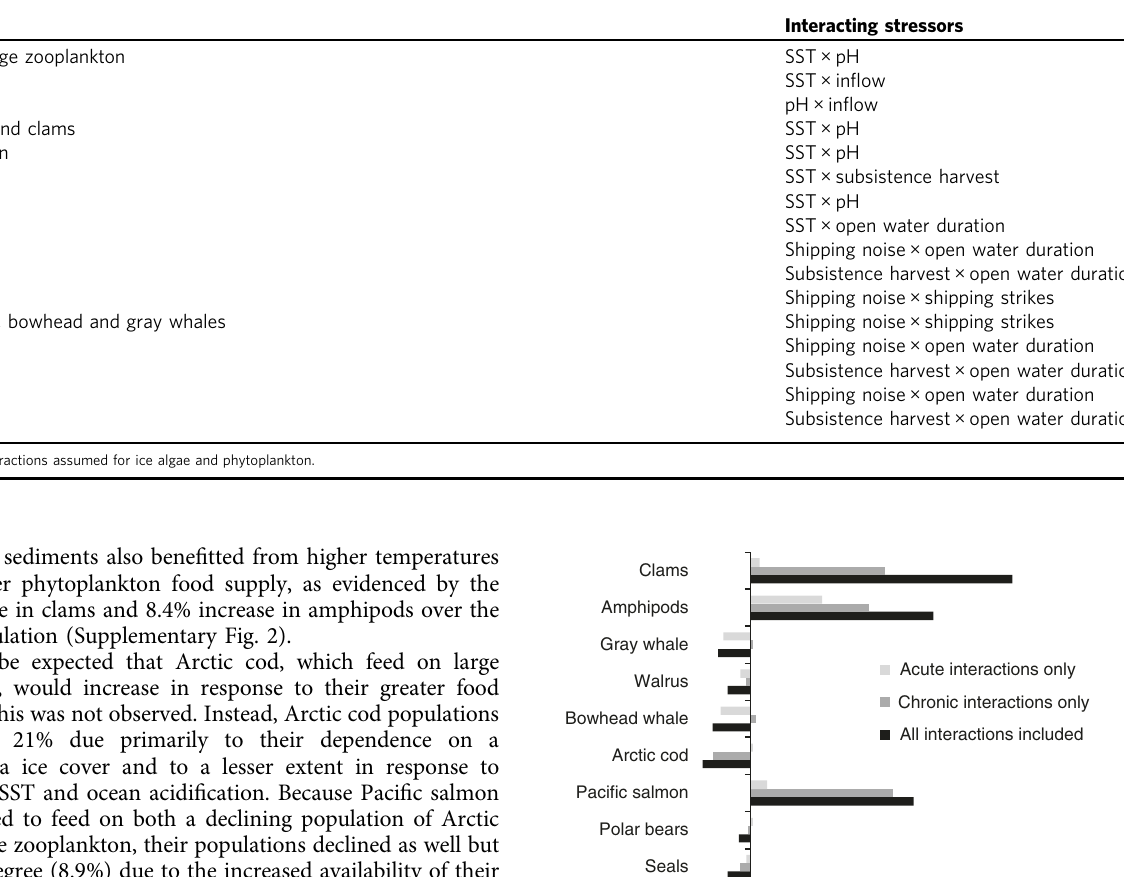
Table 1 Stressor interactions used in the simulations.